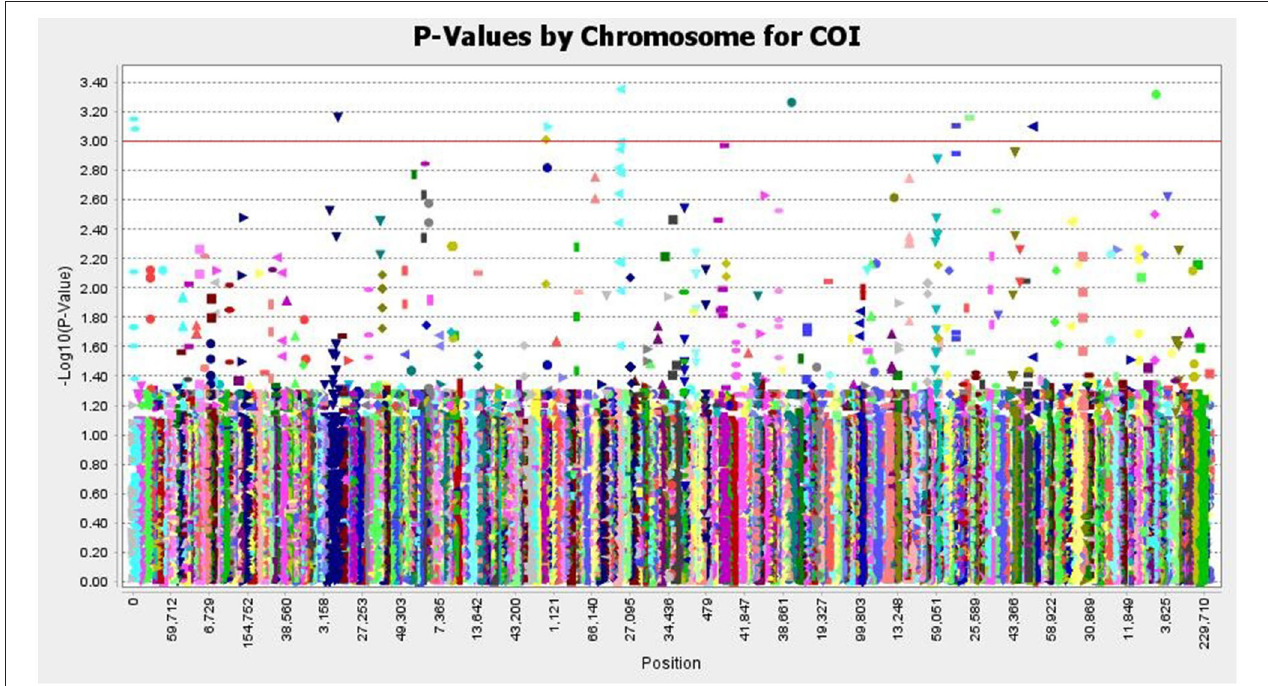
FIGURE 11 | Manhattan plots based on a mixed linear model representing - log 10 (P-values) for SNPs loci distributed throughout the T. indica genome and showing the significant virulence associated markers, The SNP positions and the genome-wide scan - log 10 (P-values) are shown on the X-axis and the Y-axis, respectively.